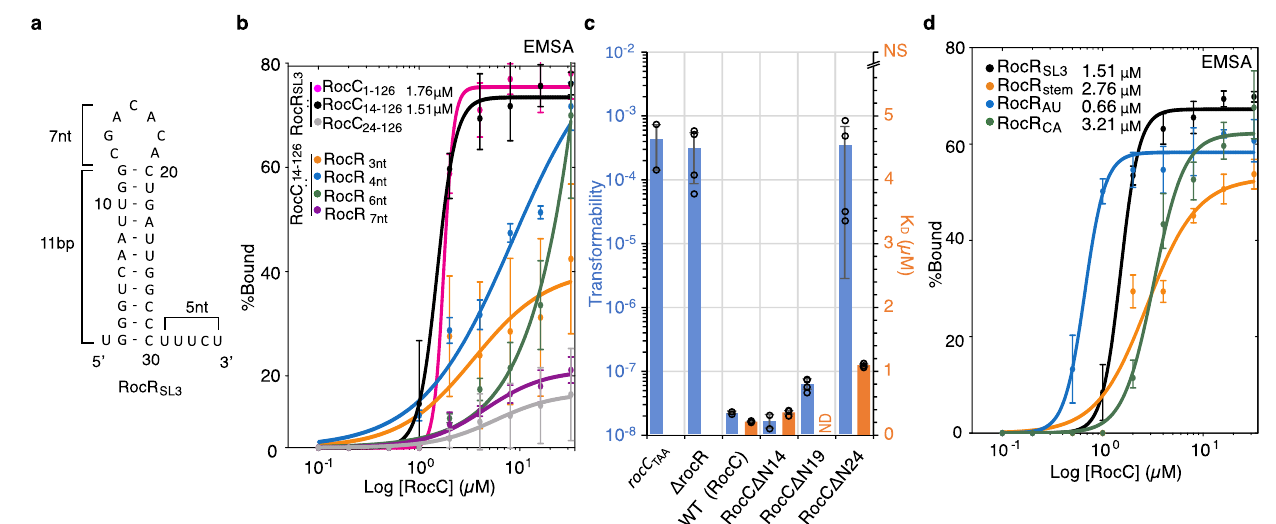
Fig.1|De fi ningthedeterminantsofRocC/RocRinteractioninvitroandinvivo. a Predictedfoldingofwild-typeRocR SL3 usingRNAfoldwebserver. b EMSAbinding assay for RocC 1-126 , RocC 14-126 , and RocC 24-126 vs 5 ’ radiolabeled RocR SL3 ( n =3). Bindingaf fi nityofRocR SL3 withdifferenttaillengthswastestedwithRocC 14-126 .The error bars are standard error of the mean (SEM). c Role of the N-terminus of RocC for RocR SL3 binding in vitro and for uptake of DNA (transformation) in vivo. The transformation was assessed in Legionella strains containing either WT RocC, a mutantinwhich rocC translationisdisrupted ( rocC TAA ),aRocRdeletion( Δ rocR ),or differentdeletionsattheN-terminus(RocC Δ N14 — deletionofa.a.1 – 13;RocC Δ N19 – deletionofa.a.1-18;RocC Δ N24 — deletionofa.a.1 − 23).Bindingmeasurementswere carried out with a fl uorescence polarization (FP) assay using RocC 1 − 126 or the indicated N-terminal deletion mutants, with FAM-labeled RocR SL3 as a target. The